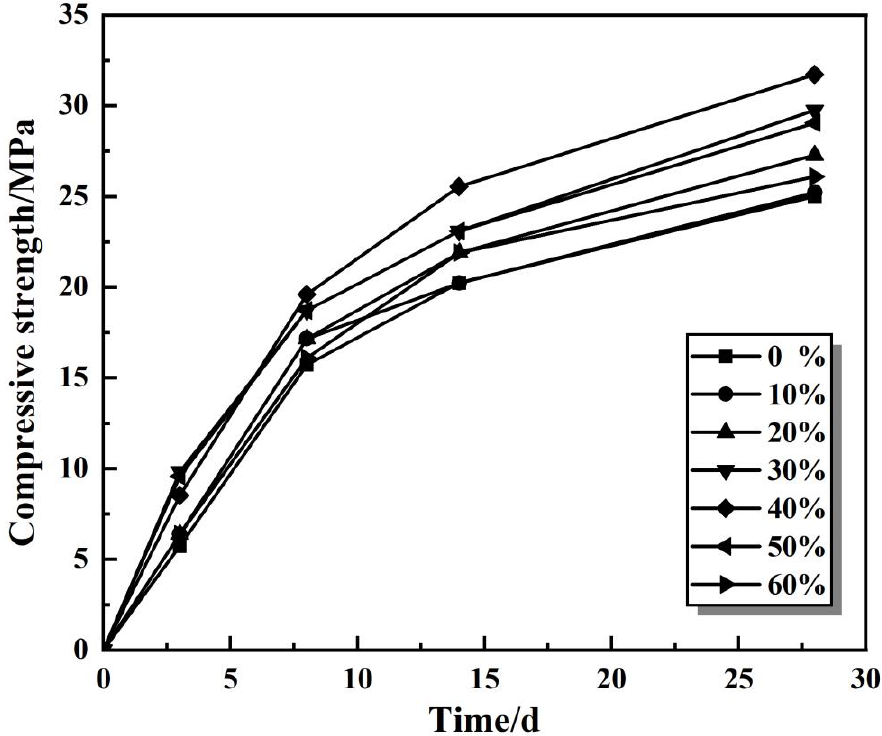
Figure 9. Compressive strength comparison of C25 concrete with different contents of lead–zinc tailings [108].